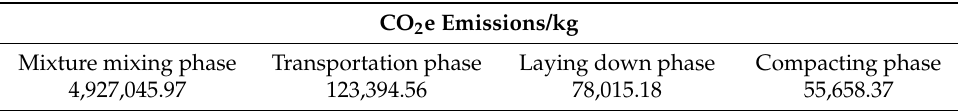
Table 6. GHG emissions for construction of asphalt course.